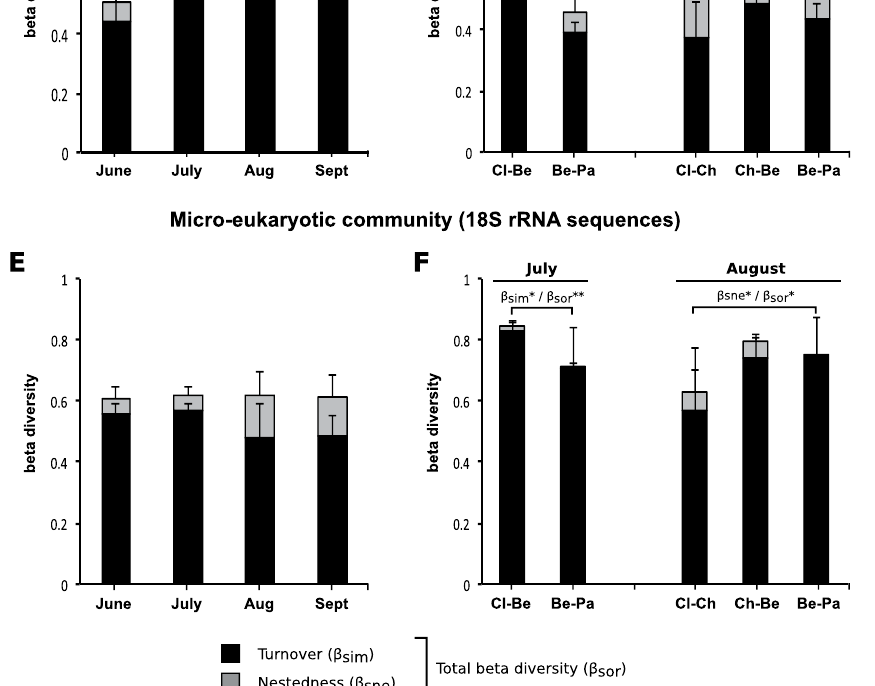
nestedness, except in bacterial communities, where a significant increase in the contribution of turnover was detected in August and September (ANOVA; df = 3, F = 9.56, P = 0.005) (Fig. 3A). Finally, regarding the sampling sites (Fig. 3B,D and F), the total beta diversity showed decreasing trends from upstream to downstream in July and August, except for the microeukaryotic communities (based on the 18S rRNA dataset) in August.